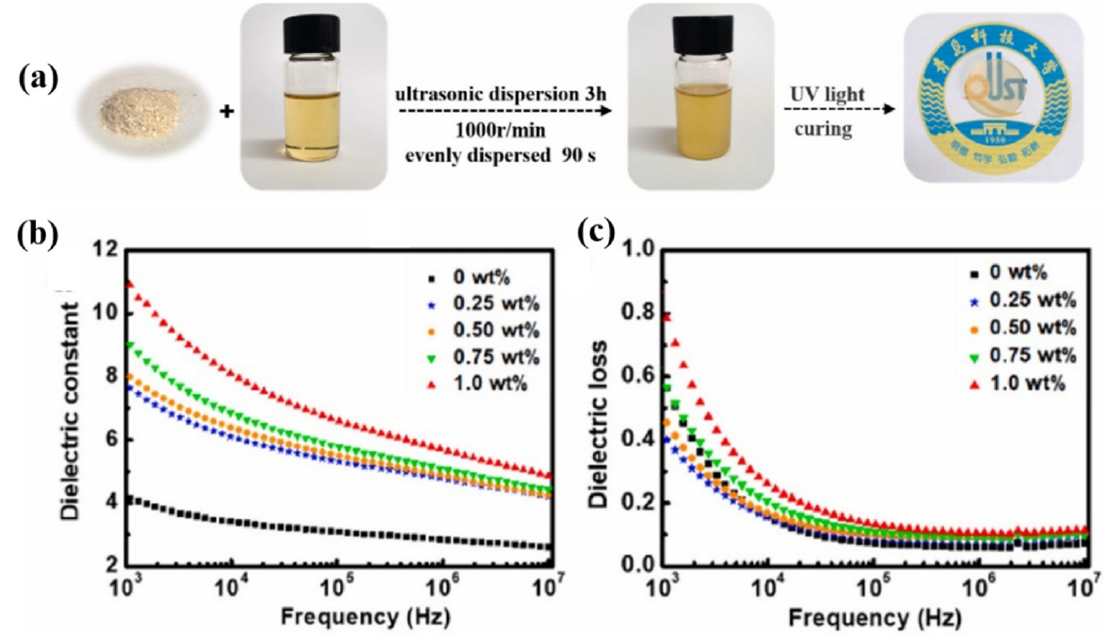
Figure 9. ( a ) preparation of MMPR/CNCs-MAA. Dielectric permittivity ( b ) and dielectric loss ( c ) of MMPR/CNCs-MAA. Adapted with permission [93]. Copyright 2022, Elsevier.